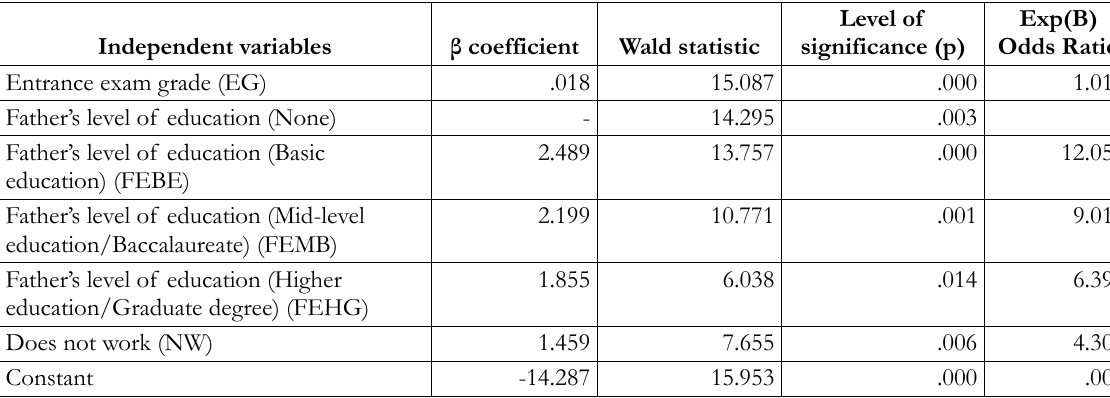
Table 4. Results of the logistic regression